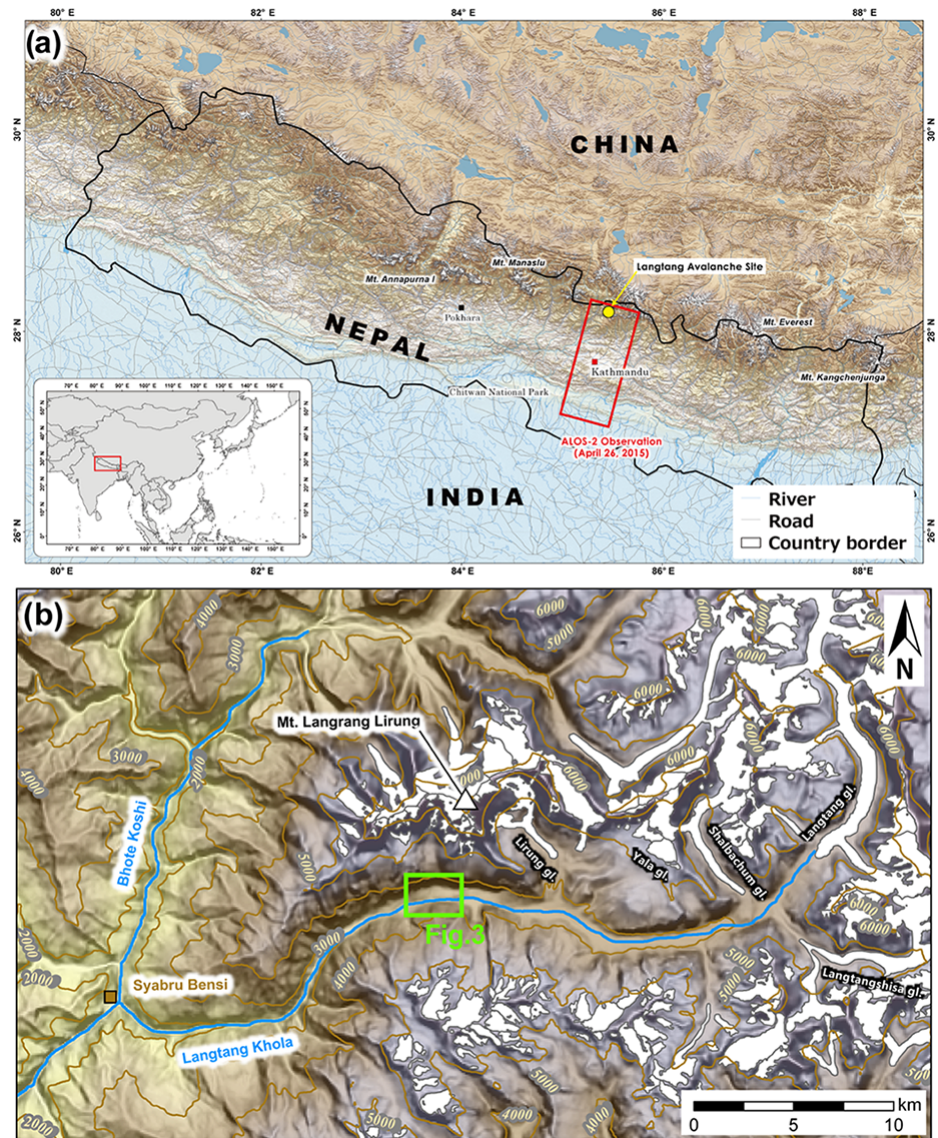
Figure 1. Location of the study site (a) in the Nepal Himalayas and (b) its close-up view. Topography obtained from NASA/USGS SRTM3v4, glacier outlines obtained from ICIMOD Mountain Geoportal, rivers and roads obtained from DIVA-GIS (partially revised), and country borders obtained from ThematicMapping.org are